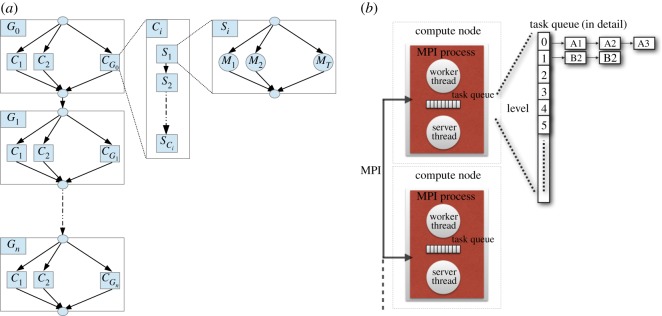
Task graph of the TMCMC algorithm (a) and parallel architecture of the TORC library (b).